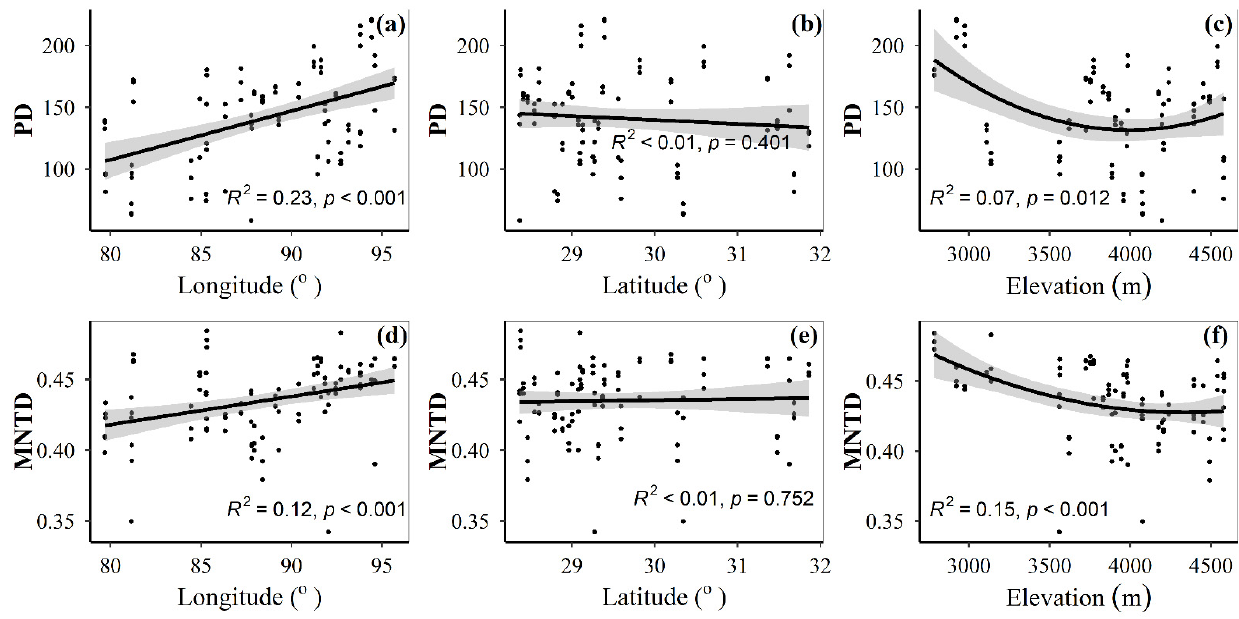
Figure A13. Relationships between phylogenetic α -diversity and geographic variables (longitude, latitude, and elevation) at 0–10 cm depth. ( a – c ) phylogenetic diversity (PD), and ( d – f ) mean nearest taxon distance (MNTD).